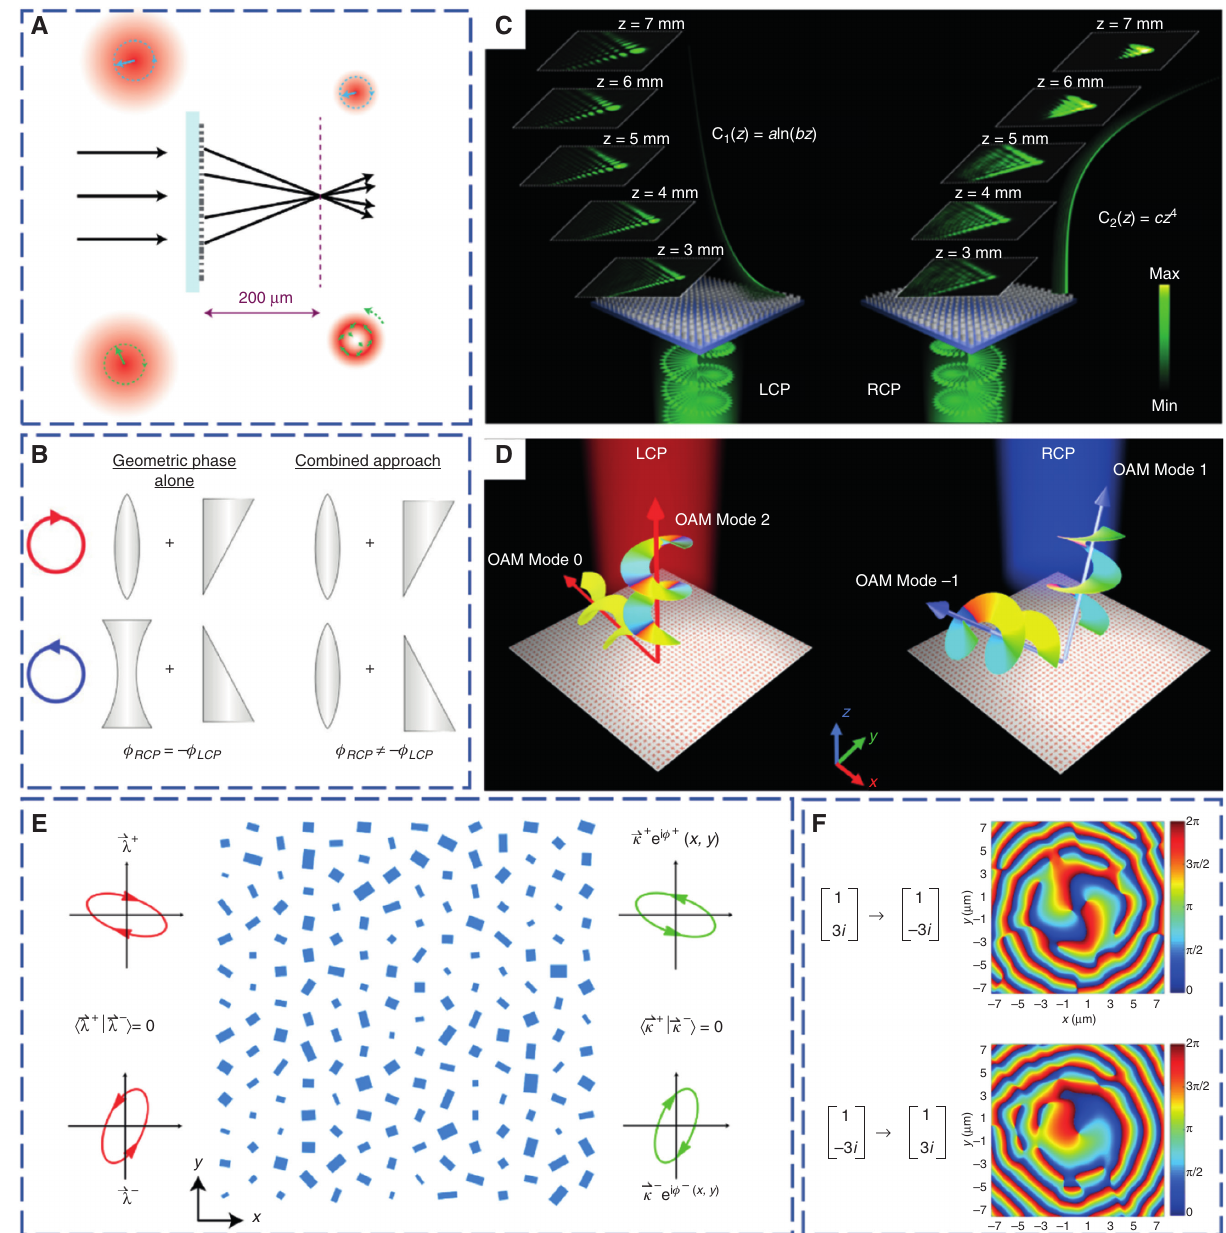
Figure 18: Nanostructured metasurfaces with three design degrees of freedom for phase manipulation in two polarization states. (A) Independent phase manipulation with incidence of two orthogonal polarized light beams [132]. (B) Metasurface design to obtain different off-axis amounts in two orthogonal polarization states [133]. (C) Metasurfaces for accelerating light with different acceleration directions and caustic trajectories [134]. (D) Metasurfaces for generating vortex beams with different topological charges [135]. (E) Independent phase manipulation of metasurfaces in two arbitrary orthogonal polarization states [136]. (F) Independent phase manipulation of metasurfaces in two arbitrary nonorthogonal polarization states [137]. Reprint permission obtained from